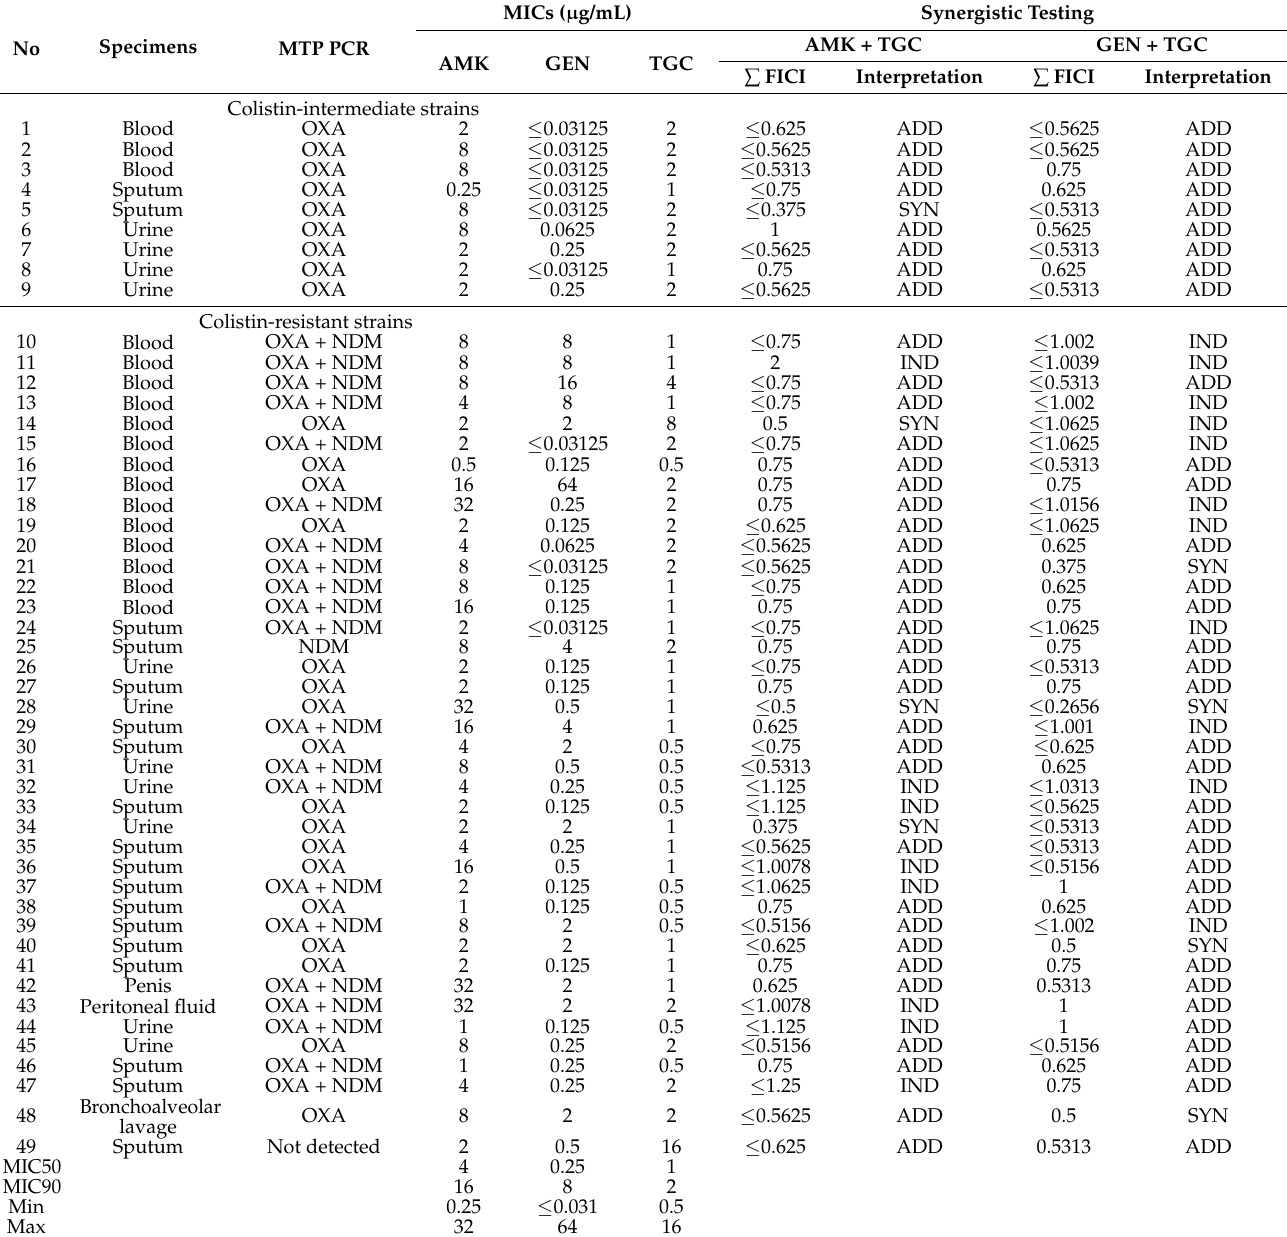
Table 2. Results of antibiotic susceptibility from the broth microdilution method, the antibiotic resistant genes from multiplex polymerase chain reaction (MTP-PCR), and synergy from the checkerboard method for all carbapenem-resistant Klebsiella pneumoniae (CRKP) isolates ( n = 49) divided by colistin breakpoints according to Clinical and Laboratory Standards Institute (CLSI)